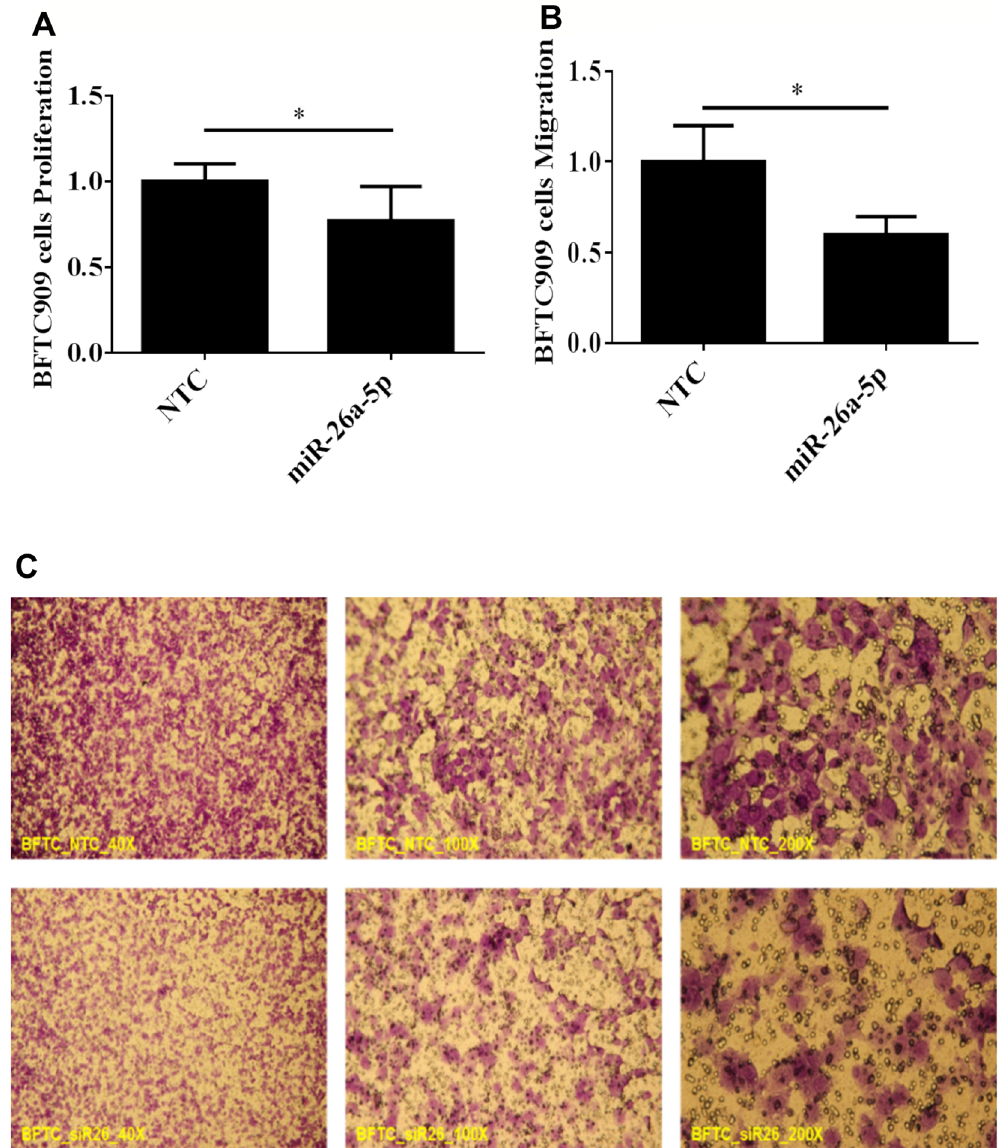
Figure 2. Restoration of miR-26a-5p suppressed proliferation and migration of UTUC cells. BFTC-909 UTUC cells were transfected with miR-26a-5p mimics, followed by WST-1 and trans-well assays. NTC denotes non- transfection controls with scrambled mimetic treatment. ( A ) After mimetic transfection for 48 h, WST-1 assay was used to evaluate cell numbers. WST-1 value is directly proportional to cell number. ( B ) After mimetic transfection for 72 h, trans-well migration assay was performed to evaluate cell migration ability. ( C ) The crystal violet-stained cells are those penetrating the trans-well membrane. All data are shown as mean ± SEM from three independent experiments. *Indicates a P < 0.05 between the indicated